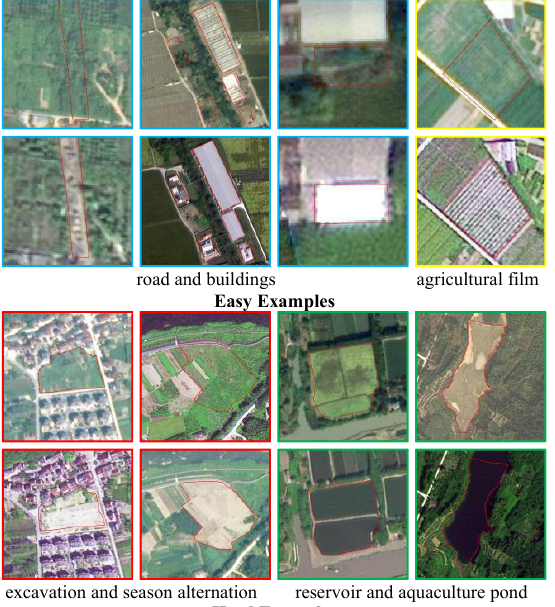
Figure 4. Typical examples of training sample Training method